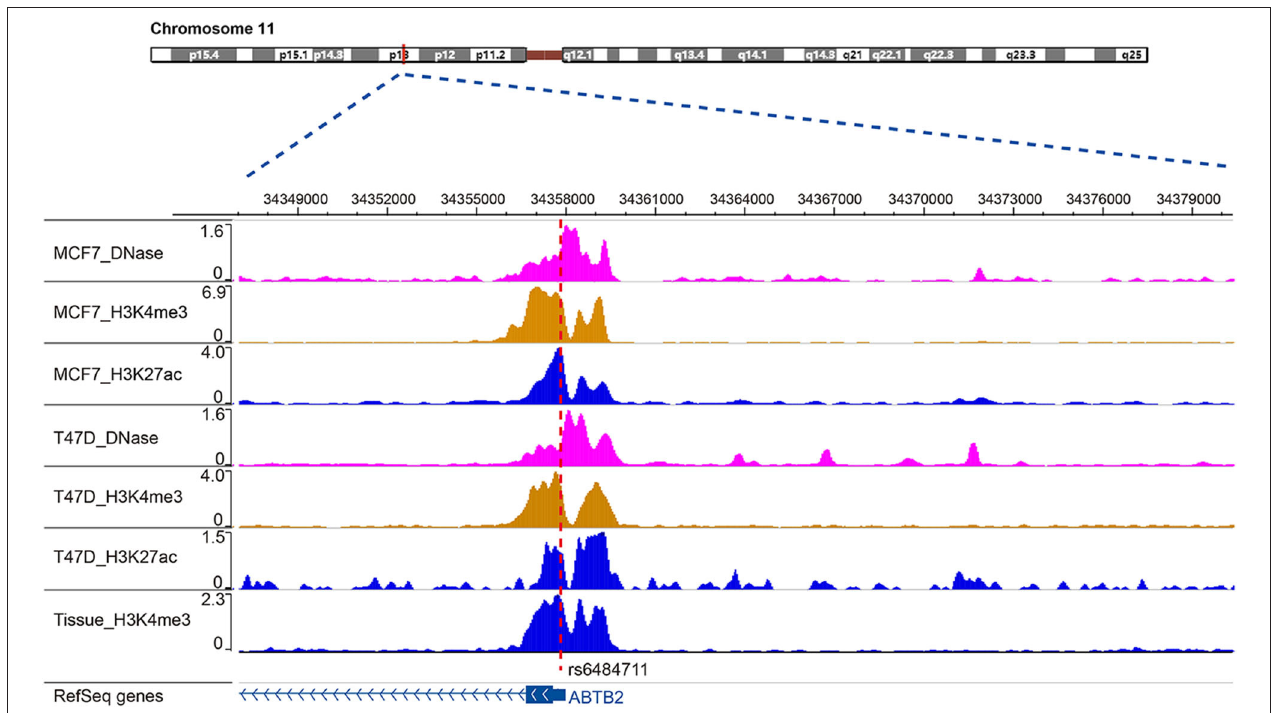
FIGURE 5 | Location of rs6484711 in the ChIP-seq peaks. Through bioinformatics analysis, rs6484711 resides in the ChIP-seq peaks of histone markers (such as H3K4me3 and H3K27ac), as well as active chromatin